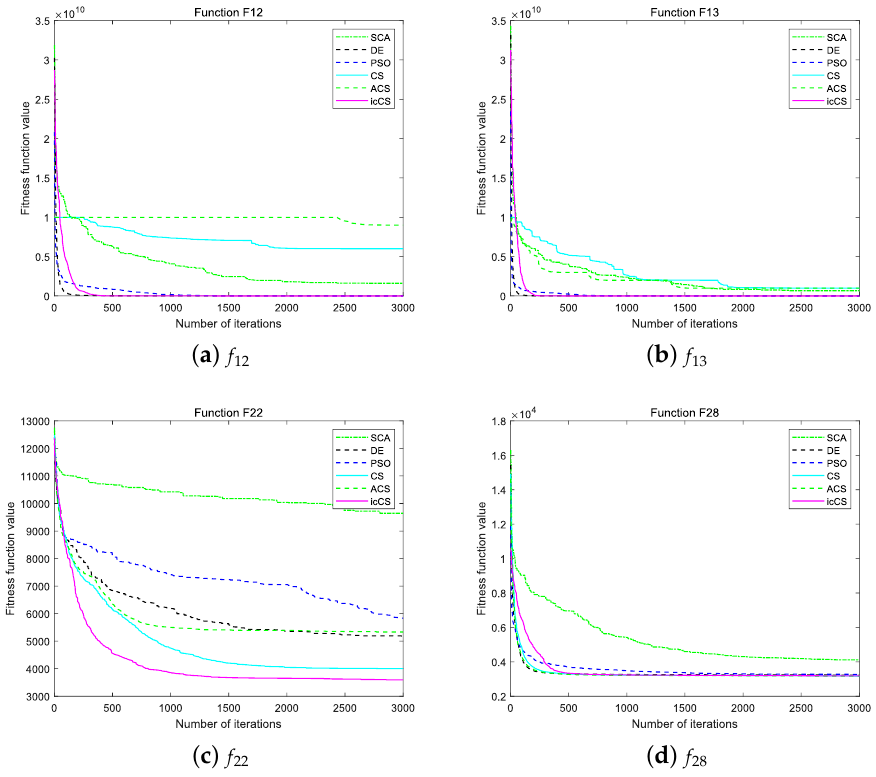
Figure 4. Convergence test results for functions f 12 , f 13 , f 22 , and f 28 in 30 dimensions: ( a ) f 12 ; ( b ) f 13 ; ( c ) f 22 ; and ( d ) f 28